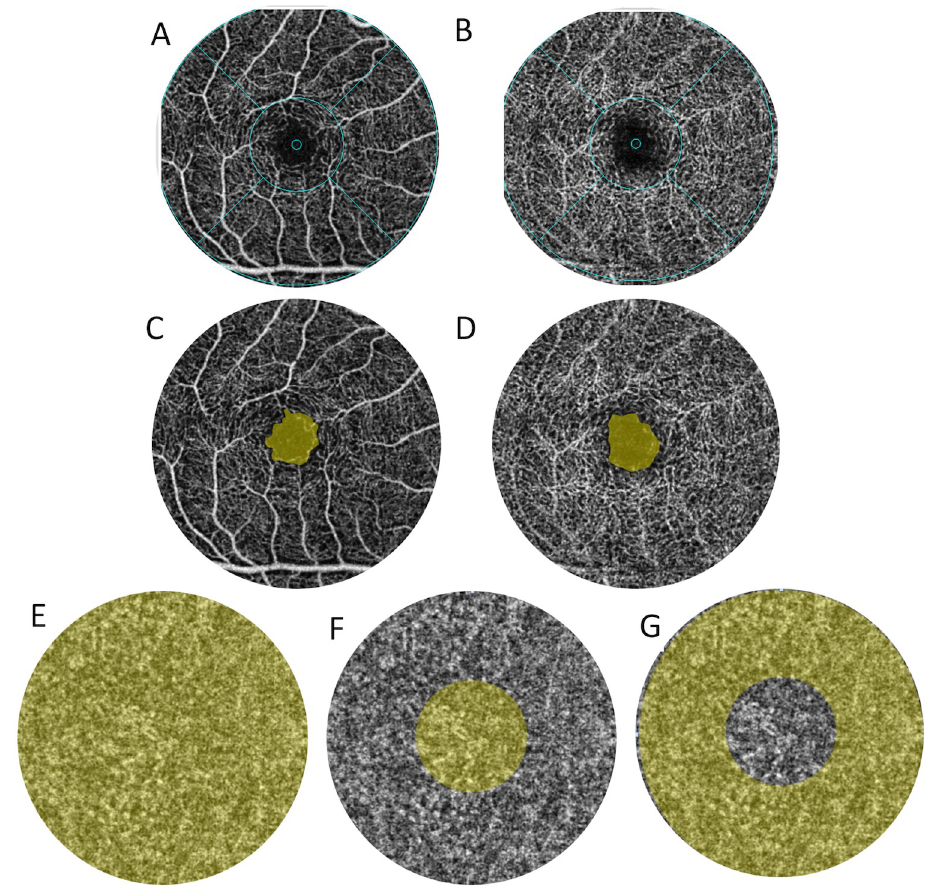
Fig 1. Methods for calculating VD, BFA, and FAZ from en face OCTA images. All images are from the same eye of a single subject. (A, B) En face OCTA images representing the VD calculated with the annulus automatically centered at the level of the SCP (A) and DCP (B). (C, D) Measurement of FAZ in the SCP (C) and DCP (D) using built-in software with OCTA AngioAnalytics. (E-G) En face OCTA images representing the areas (shaded in yellow) selected to measure the BFA in the choriocapillaris in the region below the 3x3mm macular area (E), central 1mm circular area of the fovea (F), and parafovea (G). VD = vessel density (%), SCP = superficial capillary plexus, DCP = deep capillary plexus, BFA = blood flow area (%), FAZ = foveal avascular zone (mm 2 ).